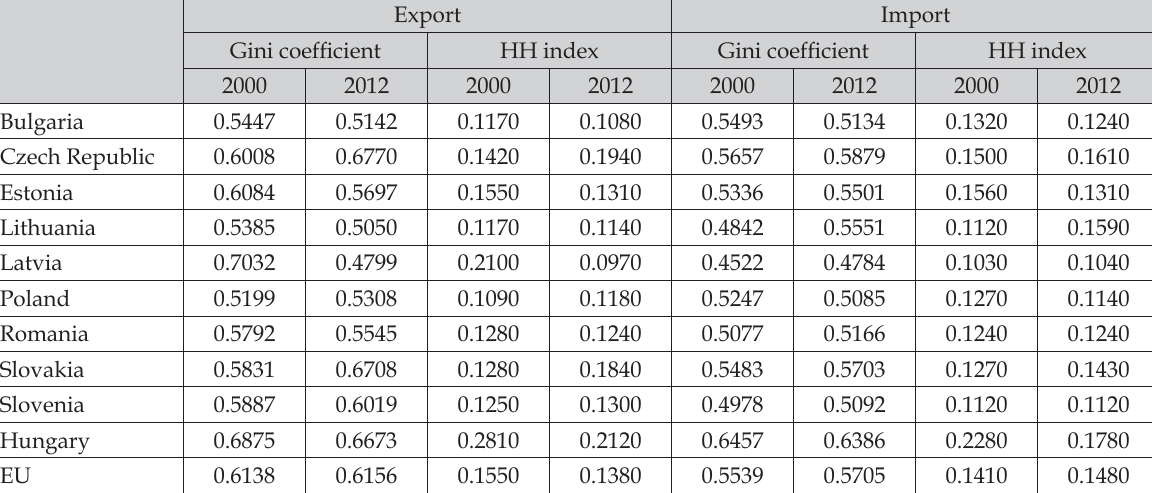
Calculations made on the basis of a two-digit level of disaggregation according to the HS classification 1988/92. Source: calculated by the authors on the basis of the UN data (2014) and the World Bank data (2014).